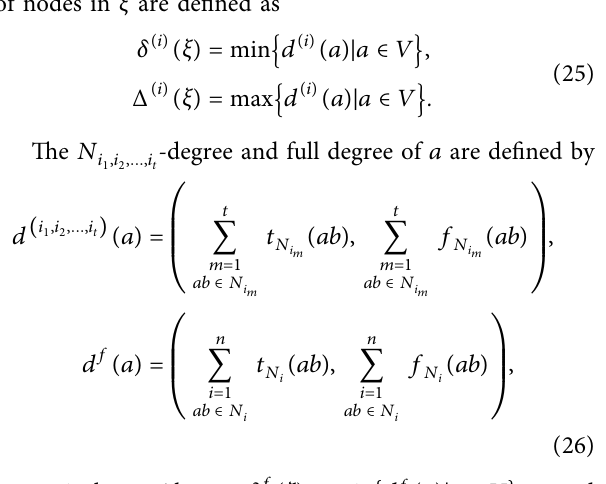
Figure 5: VGS ξ � ( M,N